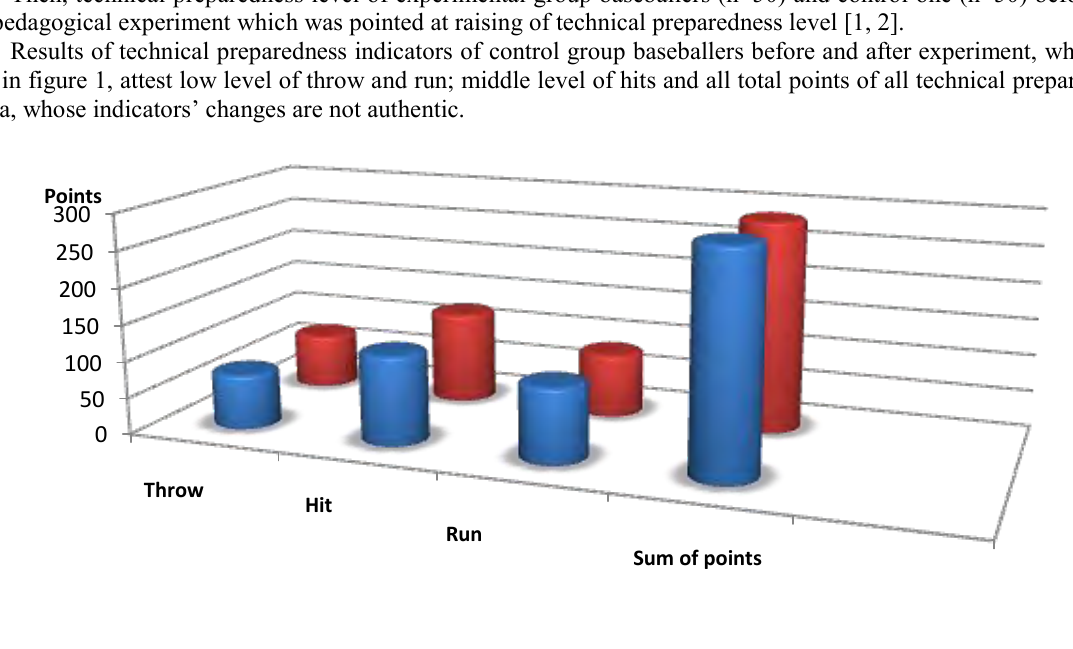
Fig. 1. Technical preparedness level of control group baseballers (n=50) before and after